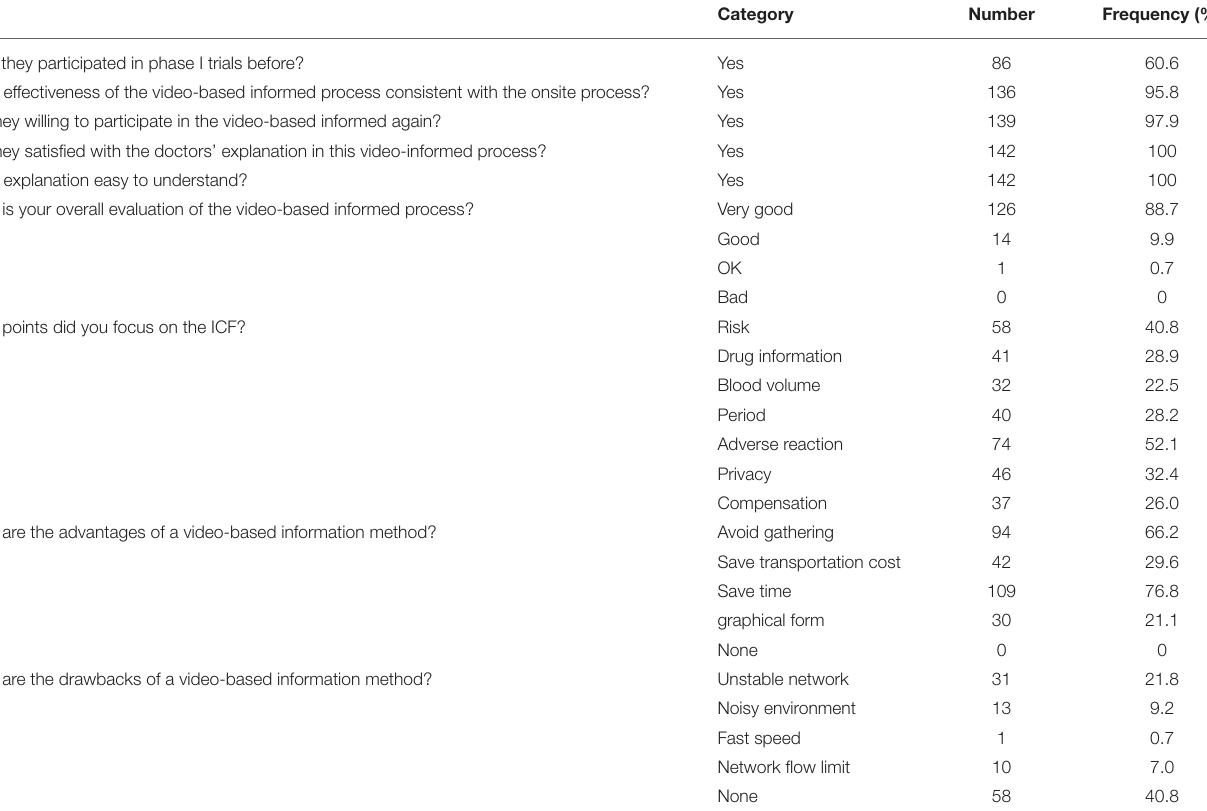
TABLE 2 | Evaluation of video informed consent process ( n = 142).